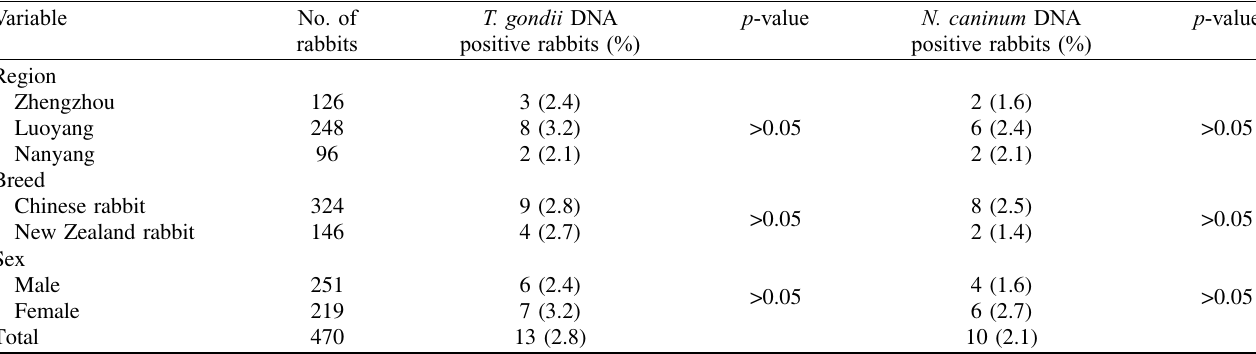
Table 1. Occurrence of Toxoplasma gondii and Neospora caninum DNA and risk factors for infection in domestic rabbits in Henan Province, central China, based on PCR.